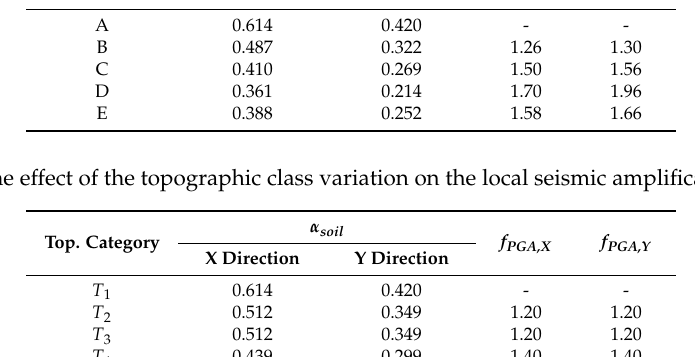
Table 3. The effect of the soil category variation on the local seismic amplification factor.